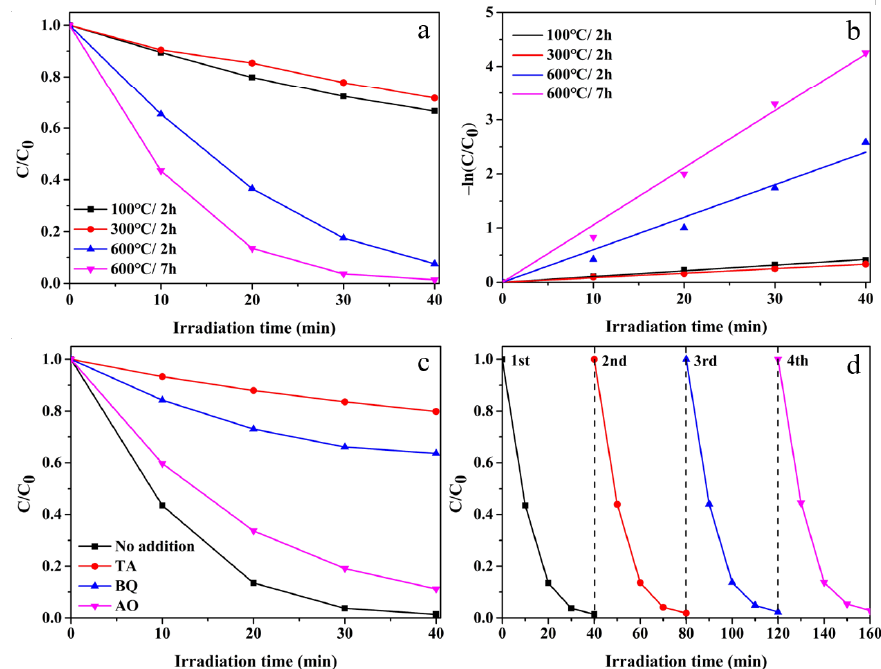
Figure 9. ( a ) Photocatalytic degradation of RhB using four samples under UV-vis light, ( b ) linear fit between −ln (C/C 0 ) and time among four samples, ( c ) trapping experiments of active species and ( d ) cyclic degradation curve of TiO 2 with annealing 600 °C for 7 h. Note: 100 °C/2 h, the precursor calcined at 100 °C for 2 h; 300 °C/2 h, the precursor calcined at 300 °C for 2 h; 600 °C/2 h, the precursor calcined 600 °C for 2 h; 600 °C/7 h, the precursor calcined 600 °C for 7 h.